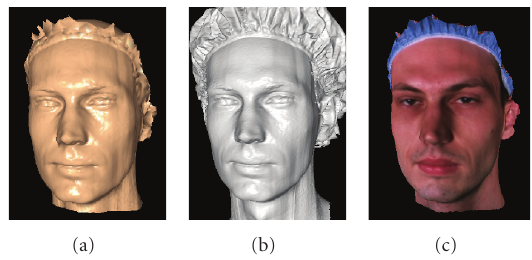
Figure 4: Model fitting: (a) deformed generic mesh after model fitting; (b) scanned model; (e) texture mapping of the deformed generic